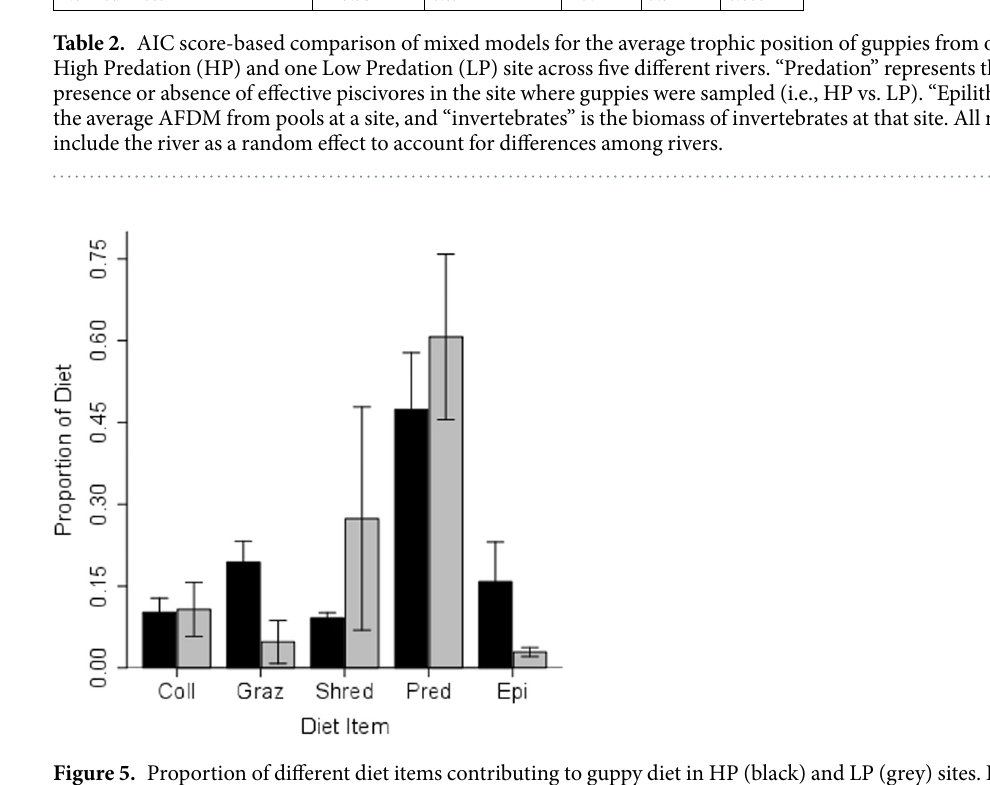
Figure 5. Proportion of different diet items contributing to guppy diet in HP (black) and LP (grey) sites. Data are proportions calculated from stable isotopes by the SIAR program, and error bars indicate standard errors. Pred = invertebrate predators; Coll = invertebrate collectors; Graz = invertebrate grazers; Shred = invertebrate shredders; Epi =